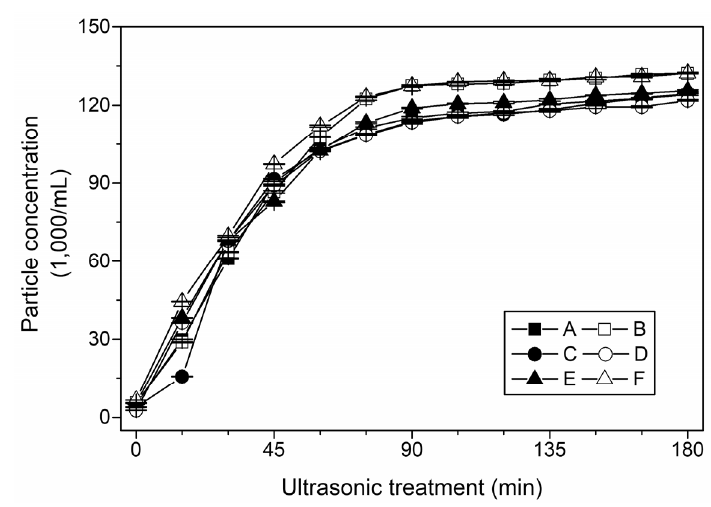
Figure 3. Particle concentrations of six batches (A–F = 20 mg / L PS particles) during ultrasonic treatment of 180 min. Error bars show standard deviation of n = 3.